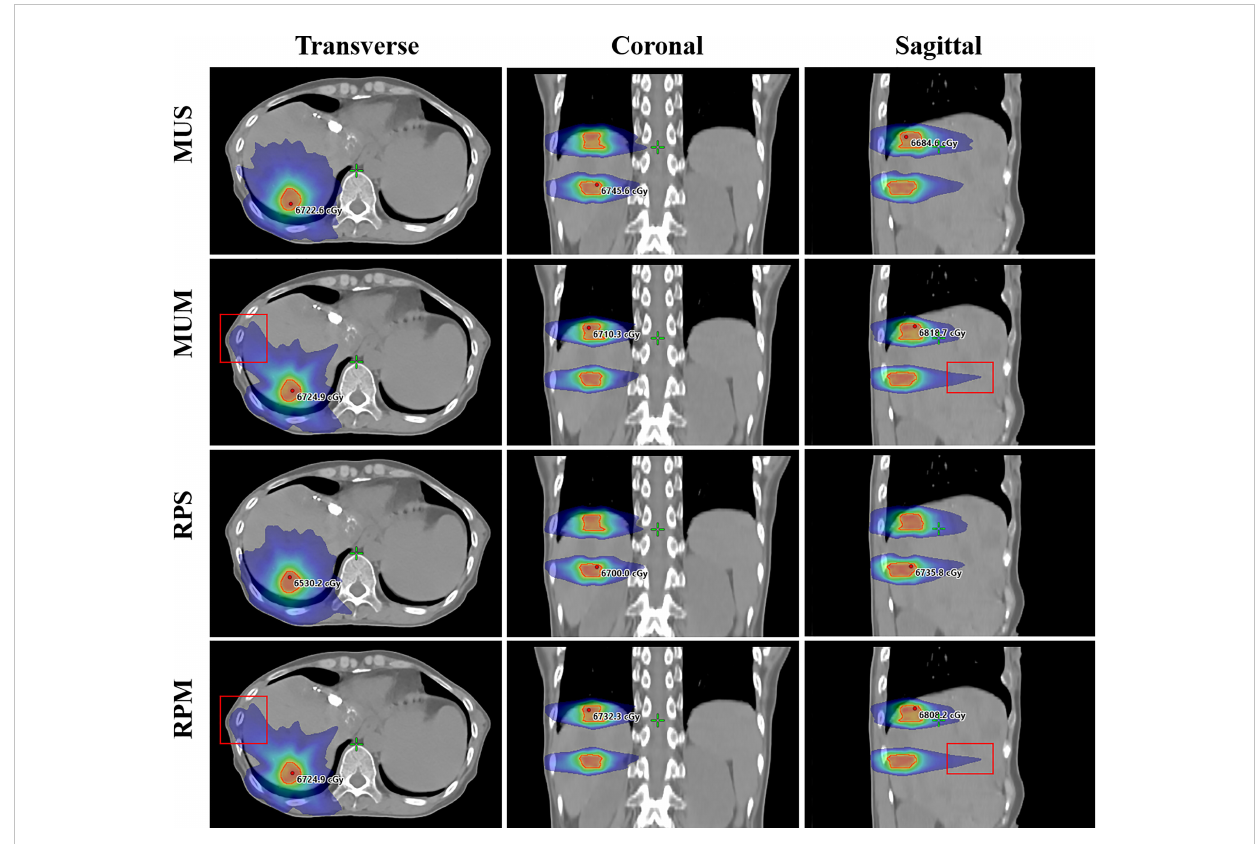
FIGURE 2 Comparison of transverse, coronal, and sagittal dose distributions for one example case.